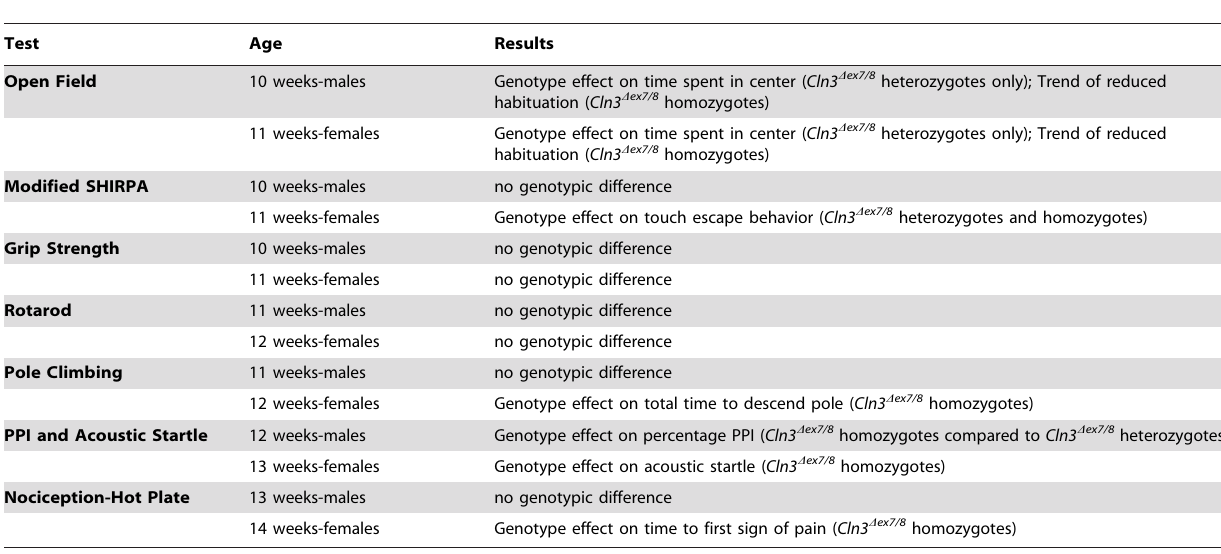
Table 1. Summary of neurological and behavioral testing of Cln3 D ex7/8